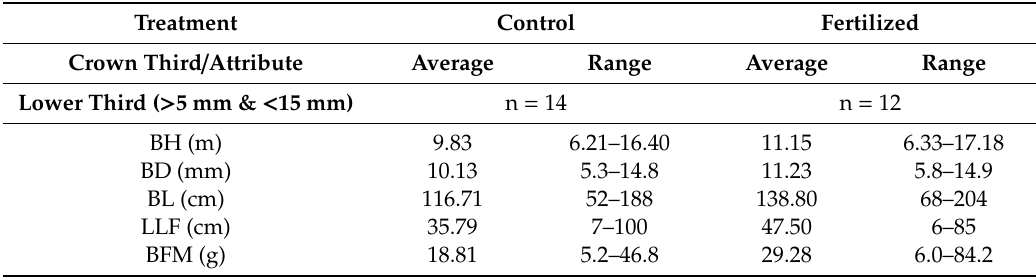
Figure 2. Relative vertical trend in total branch foliage mass (BFM; g) over relative depth into crown (RDINC; i.e., (tree height (m) − branch height (m)) / crown length (m), (H − BH) / CL)) for sampled branches on all felled sample trees. The trend line is a loess line [54] used to highlight the within-crown trend in average foliage mass per sample branch by RDINC. RDINC = 1 at crown base and RDINC = 0 at tree tip. Table 2. Averages and ranges for sample branch attributes by crown third, treatment, and branch diameter class, seven years following fertilization, including: branch height (BH), basal diameter (BD), total branch length (BL), distance from tree bole to closest live foliage on the branch (LLF), and total foliage mass